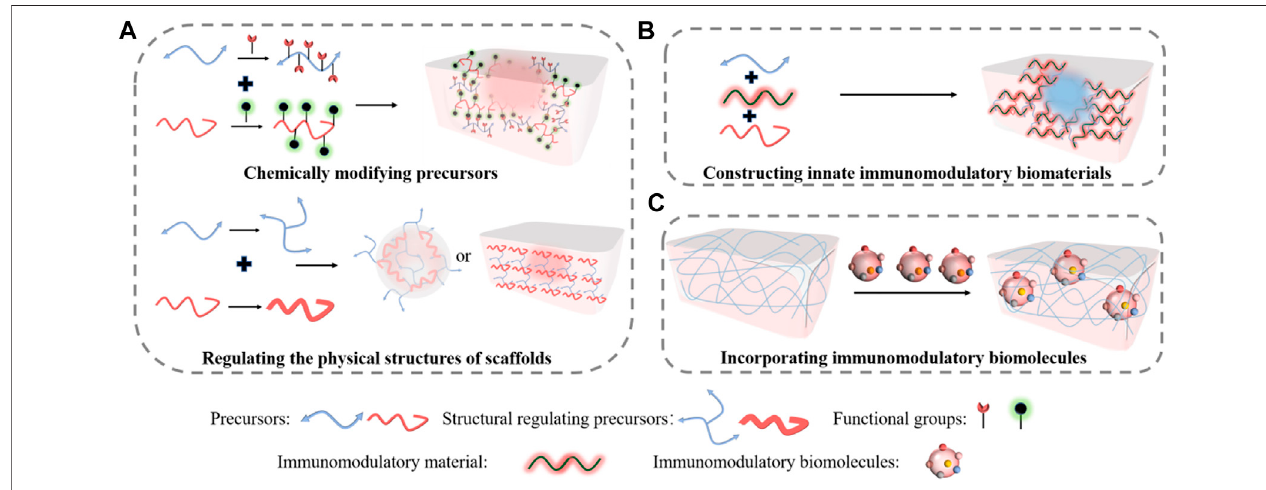
FIGURE 2 | Immuno-engineering pro-regenerative scaffolds for wound healing. (A) Either chemically modifying precursors or regulating the physical structures enabletheimmunomodulatorypropertiesofthescaffolds. (B) Constructinginnateimmunomodulatorybiomaterialsintopro-regenerative scaffoldsforskin regeneration. (C) Incorporating immunomodulatory biomolecules into scaffolds to empower the regenerative capacities for wound